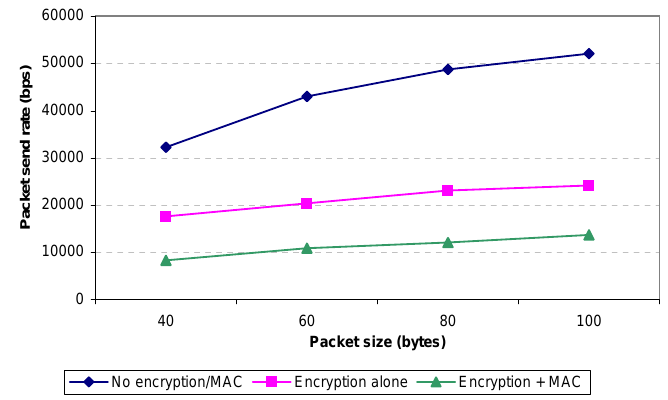
Figure 8. Throughput as a function of packet size and encryption.